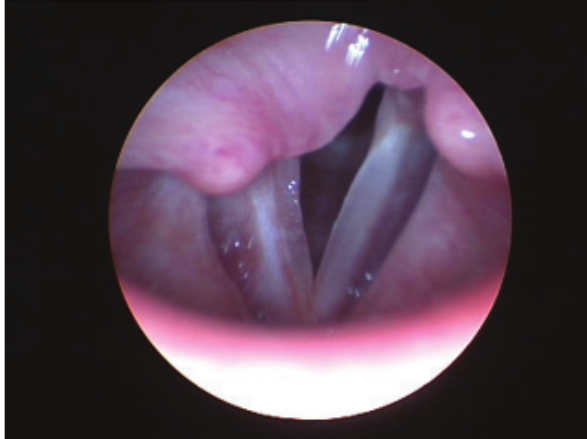
Figure 3: Videostroboscopy after the surgery: normal vocal cord movement, no pathologic masses seen on the right vocal